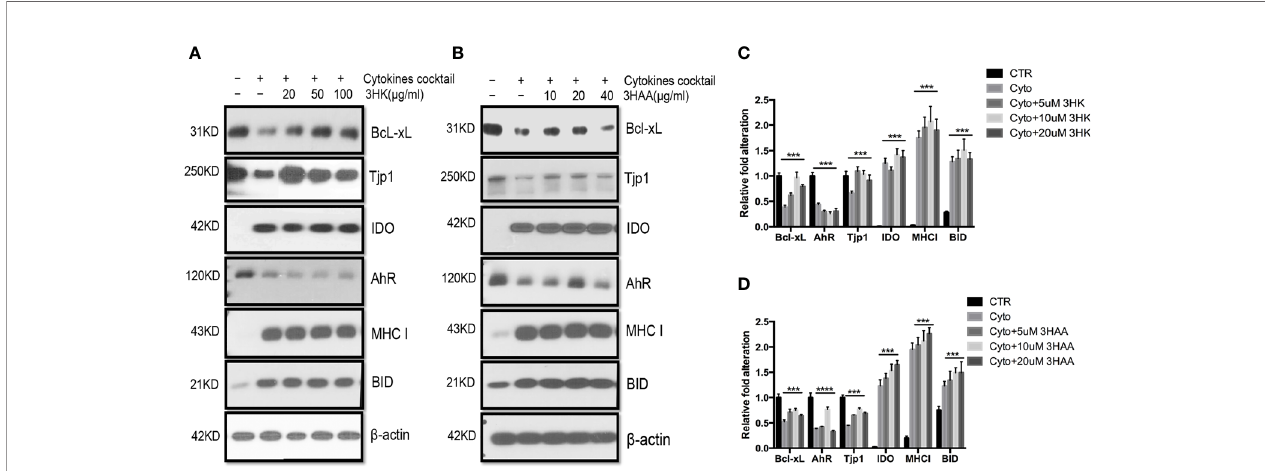
FIGURE 6 | Protective role of 3HK and 3HAA in TEC stimulated with cytokines. Primary human renal TEC pre-incubated with different doses of 3HK or 3HAA overnight; the cells are challenged with the cytokine cocktail (15 nM IFN g , 6 nM TNF a , and 3 nM IL1 b ) for 24 h; protein expression was assayed with Western blot: (A, B) 3HK and 3HAA cannot reverse IDO, MHC I, BID expression induced by cytokines. 3HK and 3HAA effectively restore Bcl-xL and Tjp1 expression. 3HAA shows its different function in up-regulation of AhR expression in TEC in in fl ammatory conditions. (C) Quali fi cation of protein expression in TEC challenged with cytokine cocktail in the presence of 3HK. *** P < 0.0001 versus cell treated with Cyto. (D) Quali fi cation of protein expression in TEC challenged with cytokine cocktail in the presence of 3HAA. *** P < 0.0001, **** P < 0.00001 versus cell treated with Cyto. Pairwise comparison of individual dose to control indicated same p-value. All Western blots are representative of three independent experiments; analysis is multiple one-way ANOVA.